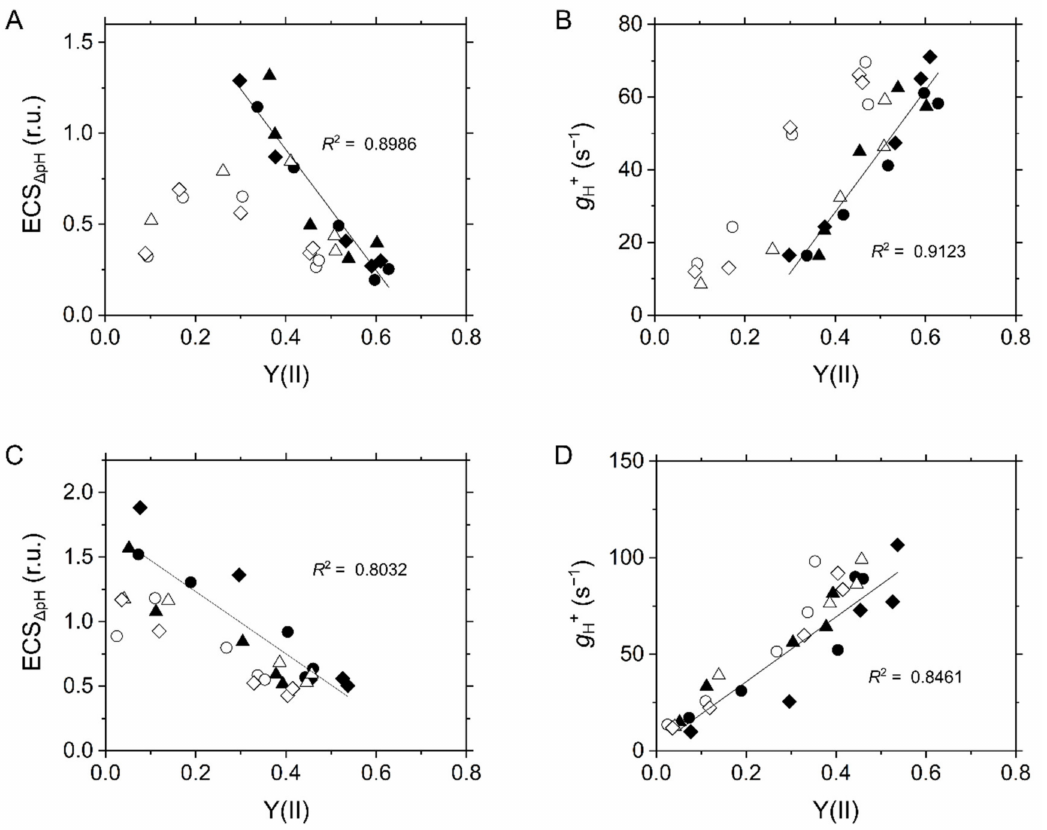
Figure 5. Relationships of the ECS values reflecting the difference of proton concentration across the thylakoid membrane (ECS ∆ pH ); ( A , C ) and the proton conductance of the chloroplast ATP synthase ( g H+ ; B, D) with effective quantum yield of PSII, Y(II), at various intercellular CO 2 partial pressures in the C 3 plant mustard ( A , B ) and the C 4 plant maize ( C , D ). We note that ∆ pH and g H+ were separately measured from Y(II) at the same ambient CO 2 partial pressures. Experiments were conducted independently three times as shown in different symbols (biological replicates) at 21 kPa (closed symbols) and 1 kPa O 2 (open symbols). Solid lines represent estimated linear regression of the data at 21 kPa O 2 ( R 2 , coefficient of